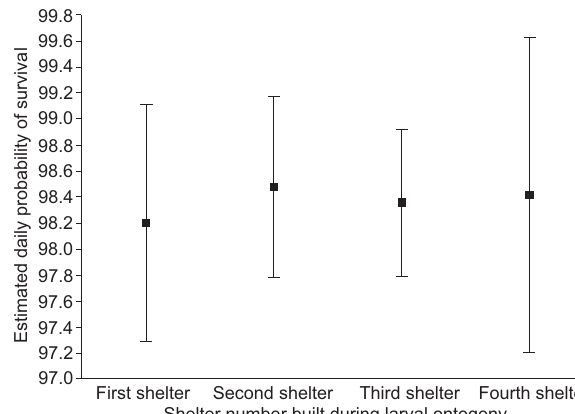
Figure 6. Comparison of the daily probability of survival (with 95% confidence intervals) of P. papius larvae in the field in the four shelters built during larval ontogeny.